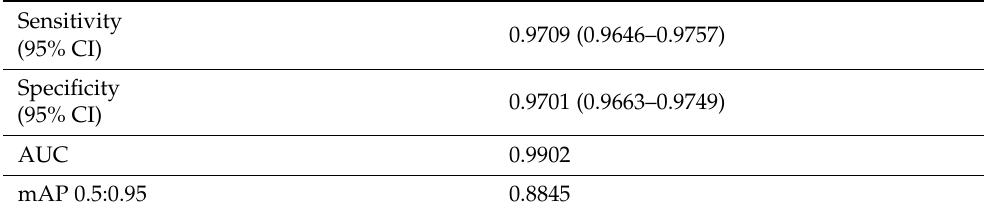
Table 1. Evaluation of deep learning detection